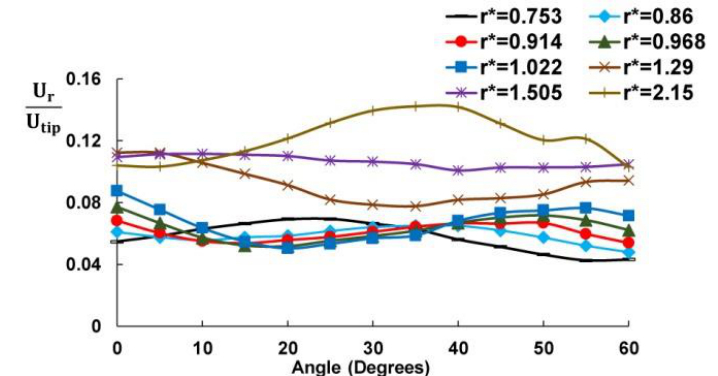
𝑈 𝑟 ⁄ at 𝑧 ∗ =-1.72 𝑈 𝑡𝑖𝑝